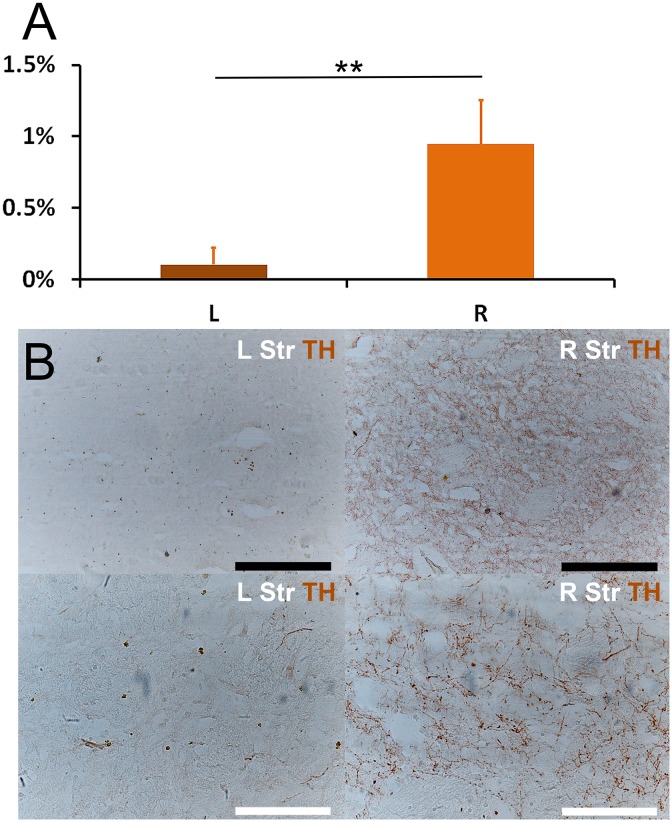
Loss of TH+ projections in striatum.The MPP+ infused monkey had severe lateral loss of TH+ projection. (A) The percentage of area of TH+ projection was defined as the ratio of TH+ area / total area in a particular field of view, and was automatically calculated with ImageJ. A nonparametric median test showed significant difference between left and right striatum (** P < 0.001). (B) Microscopic images of the left and right striatum. Right striatum had clear DA projections (TH+), which were stained as spots (transverse section) or fibers (longitudinal section). In contrast, left striatum had few stained spots and fibers, which suggested a remarkable loss of DA projections. Scale: white bar = 200 μm, black bar = 400 μm.